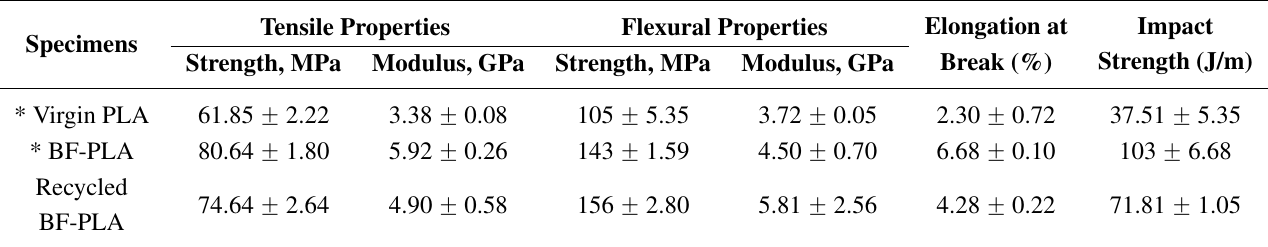
Mechanical properties of virgin PLA, BF-PLA composites and recycled BF-PLA